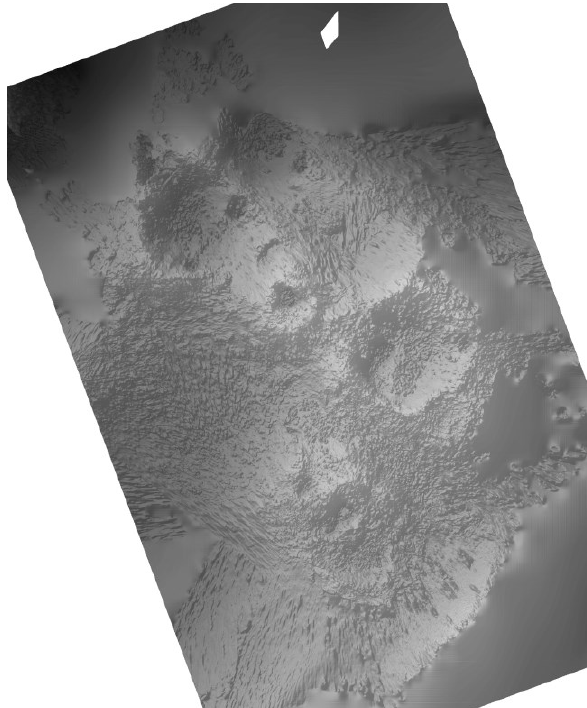
Figure 4. Raster DTM created from terrestrial